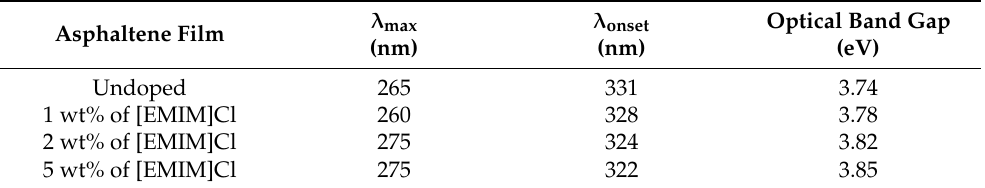
Table 4. Maximum wavelength, onset wavelength and optical band gap for undoped and [EMIM]Cl-doped asphaltene thin films.